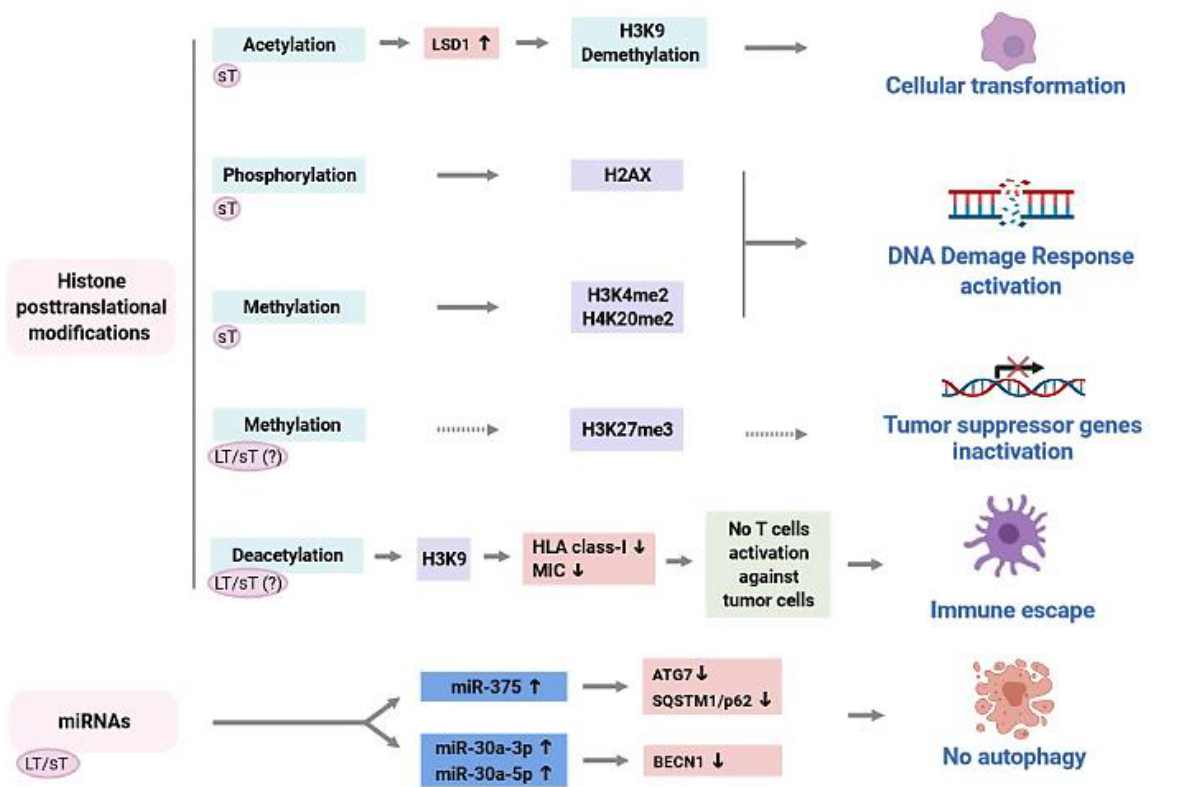
Figure 2. Impairment of epigenetic mechanisms in Merkel cell polyomavirus (MCPyV)-driven Merkel cell carcinoma. MCPyV sT promotes LSD1 expression through histone acetylation activation to induce cellular transformation. MCPyV sT can induce H2AX phosphorylation and H3K4 and H4K20 dimethylation (H3K4me2 and H4K20me2), thereby leading to the DNA damage response pathway activation. Tumor suppressor genes silencing via H3K27me3 mark might be a mechanism in MCPyV-driven MCC tumorigenesis. Loss of HLA class-I and MICA/B expression via H3K9 deacetylation might represent a strategy to evade the antiviral/-tumoral immune response. MCPyV LT/sT expression can upregulate miRNAs targeting genes involved in autophagy/cell death, such as ATG7 , SQSTM1/p62, and BECN1 . Continuous arrows— epigenetic dysregulation determined functionally in vitro. Dashed arrows—hypothesized epigenetic mechanisms. LT/sT (?)—the role of MCPyV LT/sT proteins has not been